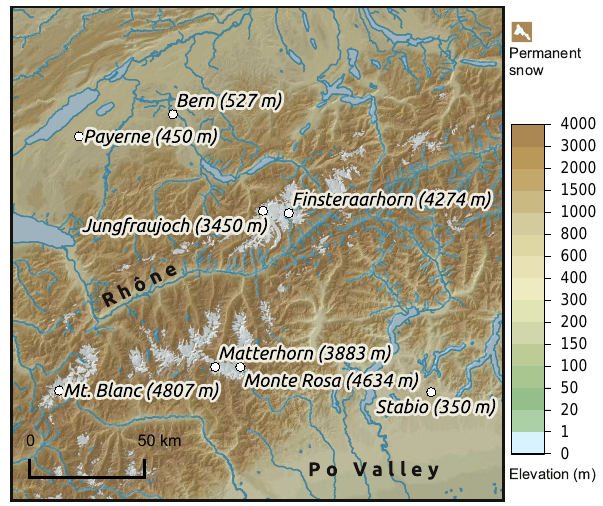
Figure 1. Jungfraujoch region. Radon detectors are installed at Jungfraujoch and Bern, separated horizontally by